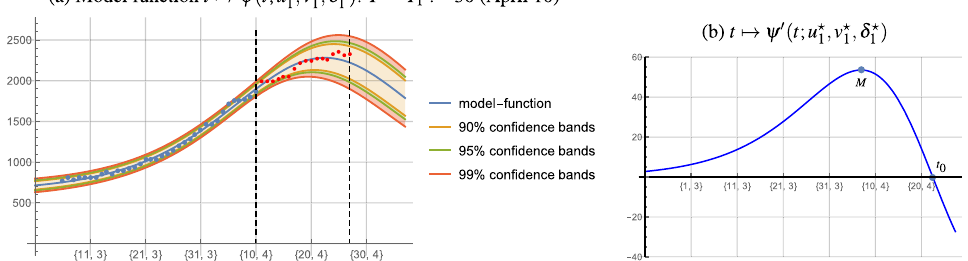
Figure 3. Numbers of hospitalized, the model function ψ with confidence bands for the fit, and the derivative 50 ). ψ ′ ( T 1 :=